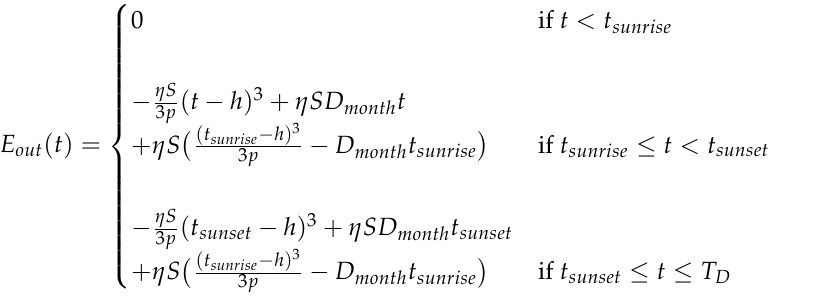
t . Figure 16 plots the evolution of E ( t , X ) during